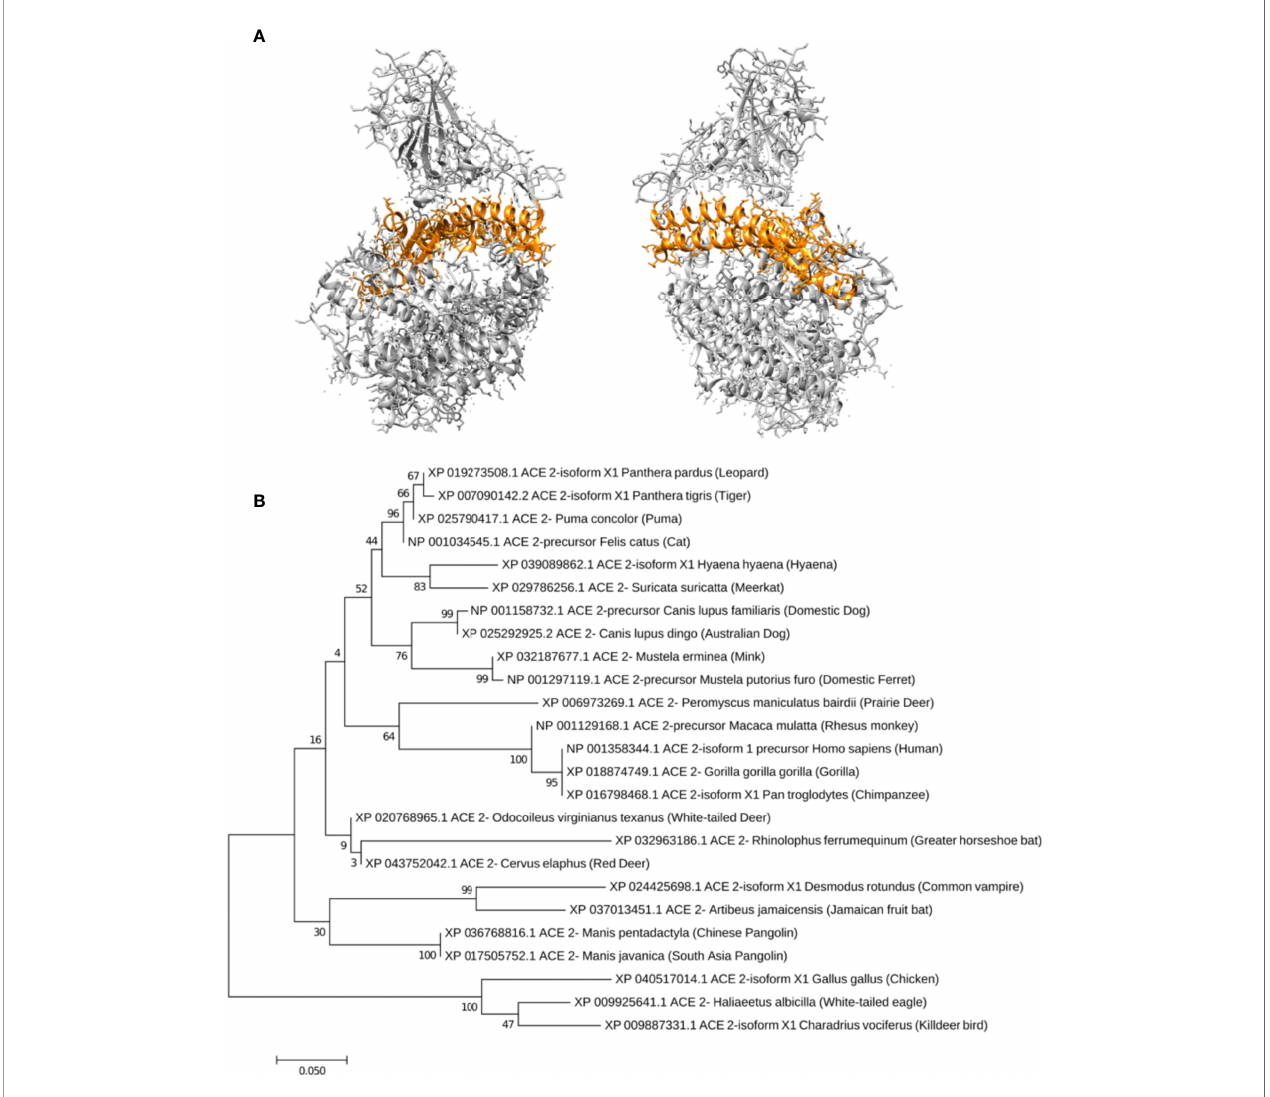
FIGURE 6 | Phylogenetic analysis of the residues near the receptor-viral RBD interface. (A) shows the structure of the human ACE2-viral RBD complex (PDB ID 6lzg), for both front and 180 degrees rotated views, with the residues at or near the receptor-viral RBD depicted in orange, whereas the remainder of the ACE2 receptor PD domain and the viral RBD domain are colored in light grey. The alignment of latter residues (19-90 and 324-393) were used to construct a phylogenetic tree, shown in (B) . The latter tree in panel B demonestrats a midpoint rooted maximum likelihood where the related taxa and closed branches are clustered together. The tree displays the evolutionary analysis of ACE2 receptor ’ s residues in contact with the viral RBD in different species and their relationship.